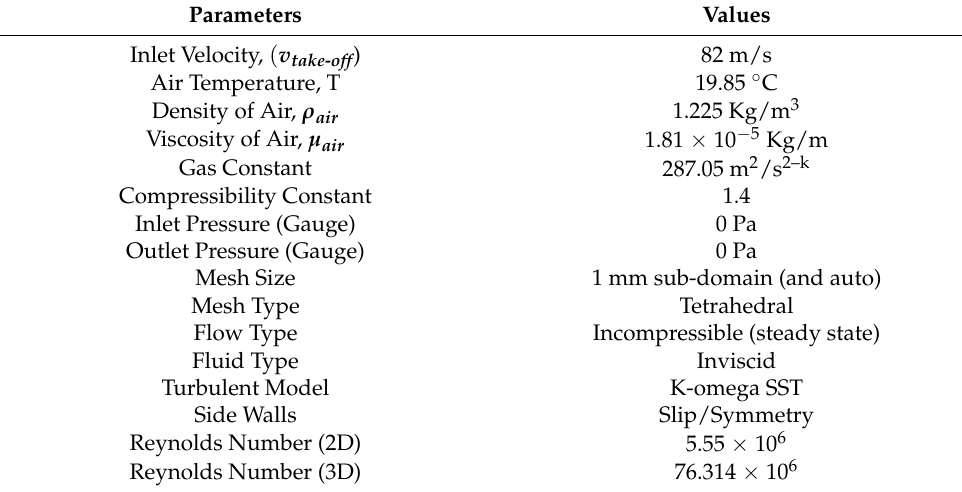
Table 3. Parameters for the Initial Boundary